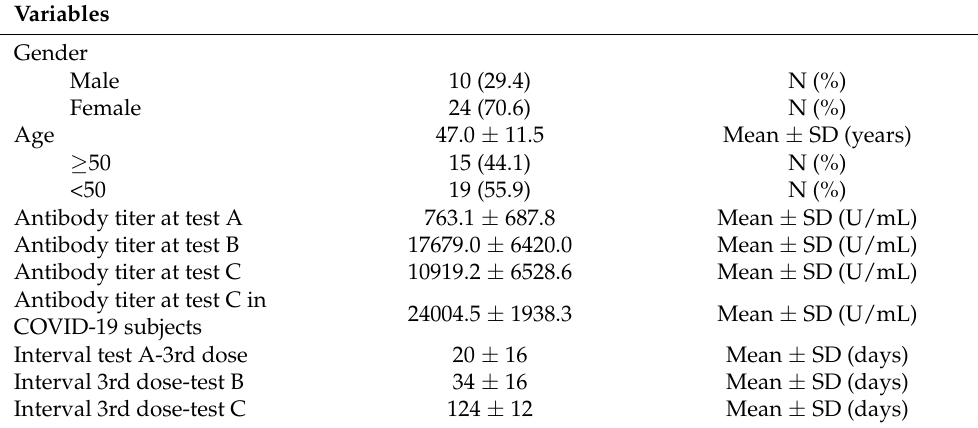
Table 1. Characteristics of the study cohort, antibody titers, and time interval between booster dose and serological tests. (Test A: prior booster; Test B: one month after booster; Test C: four months after booster).